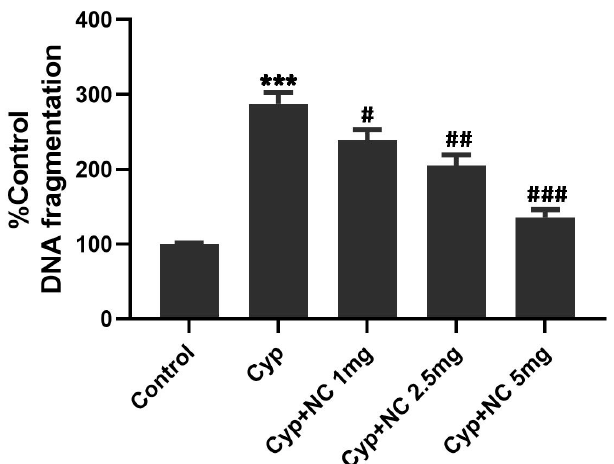
Figure 6. Effects of Cur-NLC on Cyp induced DNA fragmentation in the liver. DNA represented by nucleosomal fragments that show the degree of fragmentation induced by agents alone or in combination. Results are mean ± SEM with n = 5 rats per group. Values expressed as *** p < 0.001 vs. control, # p < 0.05, ## p < 0.01, ### p < 0.001 vs. Cyp-treated group. Cyp = cypermethrin; NC =